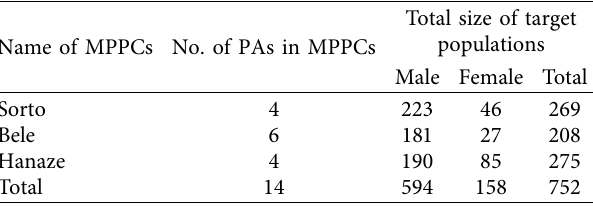
Table 2: Selected MPPCs and their members in the study